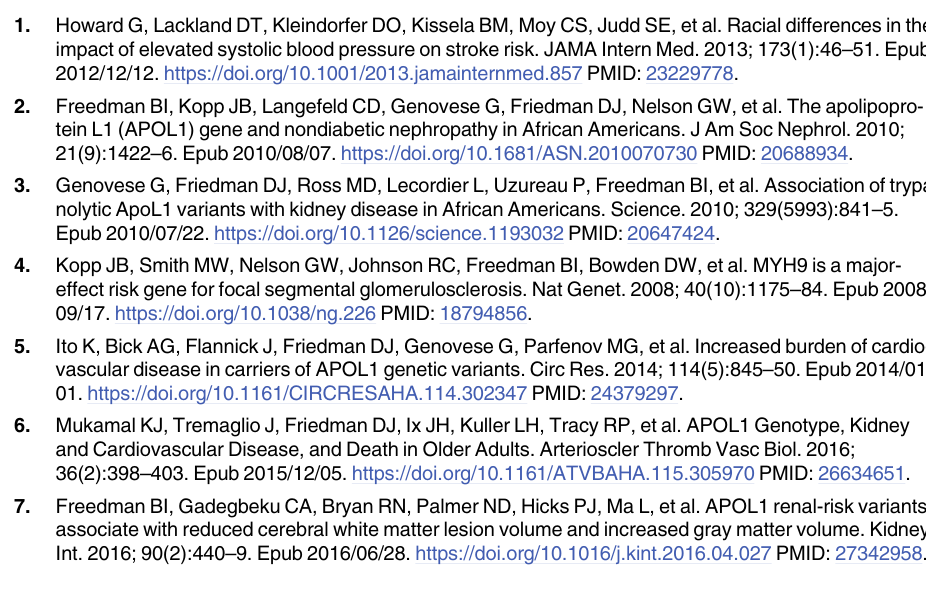
S4 Table. Baseline characteristics of GERA2 cohort versus remaining cohorts. S5 Table. Other SNPs associated with blood pressure response, according to APOL1 geno- type. S6 Table. Changes with blood pressure drugs by APOL1 genotype, additive